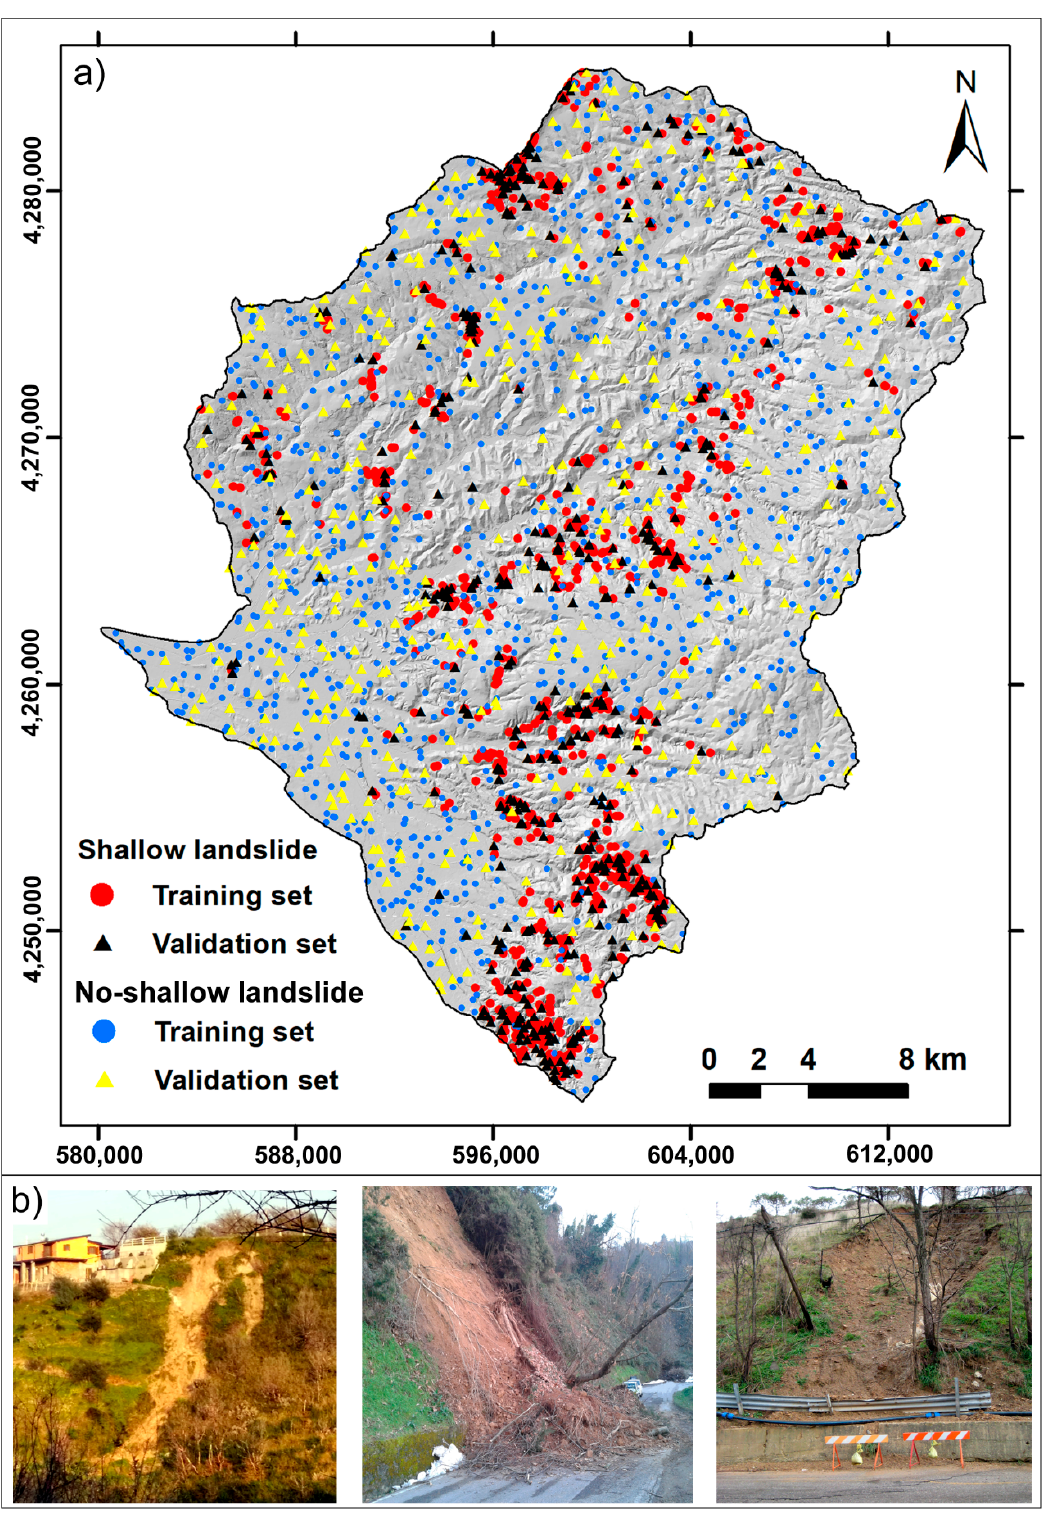
Figure 3. ( a ) Map of shallow landslide and no-shallow landslide points; ( b ) Examples of shallow landslides in the study area.